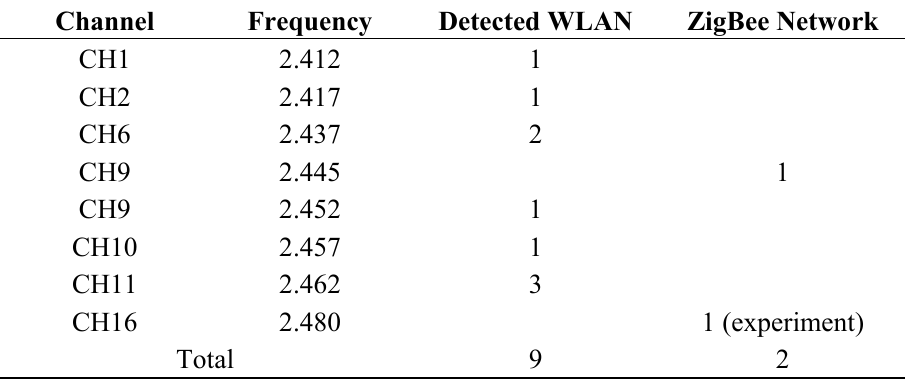
Table 5. Frequency band usage of testing environment.